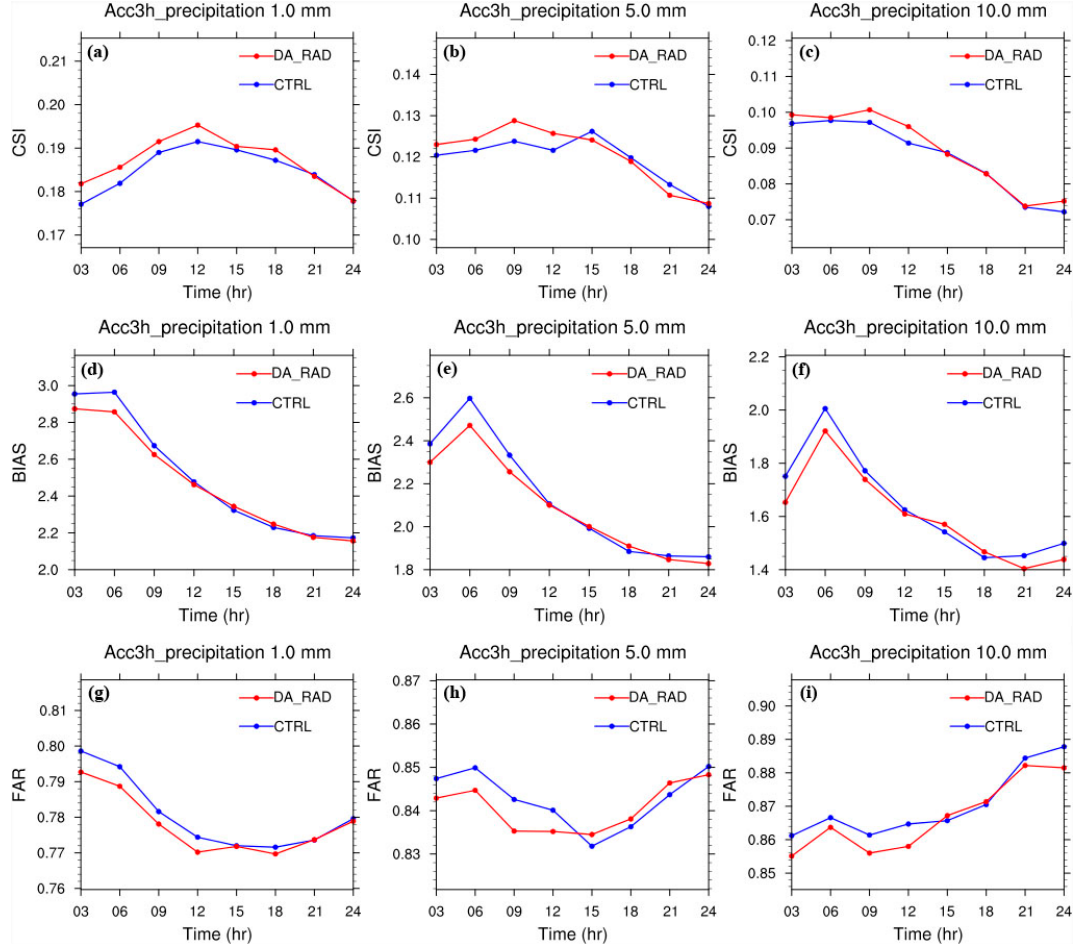
Figure 13. The average CSI ( a – c ), BIAS ( d – f ), and FAR (false alarm ration) ( g – i ) for the 3-h accumulated precipitation in Domain 1 with thresholds of 1.0 mm, 5.0 mm, and 10.0 mm .